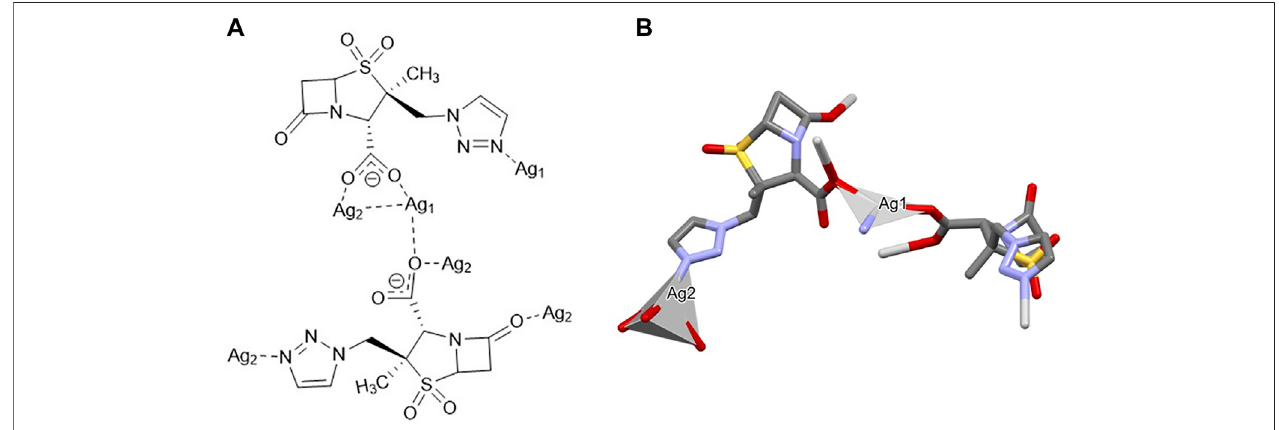
FIGURE2| Schematicrepresentationof (A) thecoordinationsitesand (B) thecoordinationgeometryaroundtheAg(I)sites(hydrogenatomshavebeenomittedfor clarity reasons) for